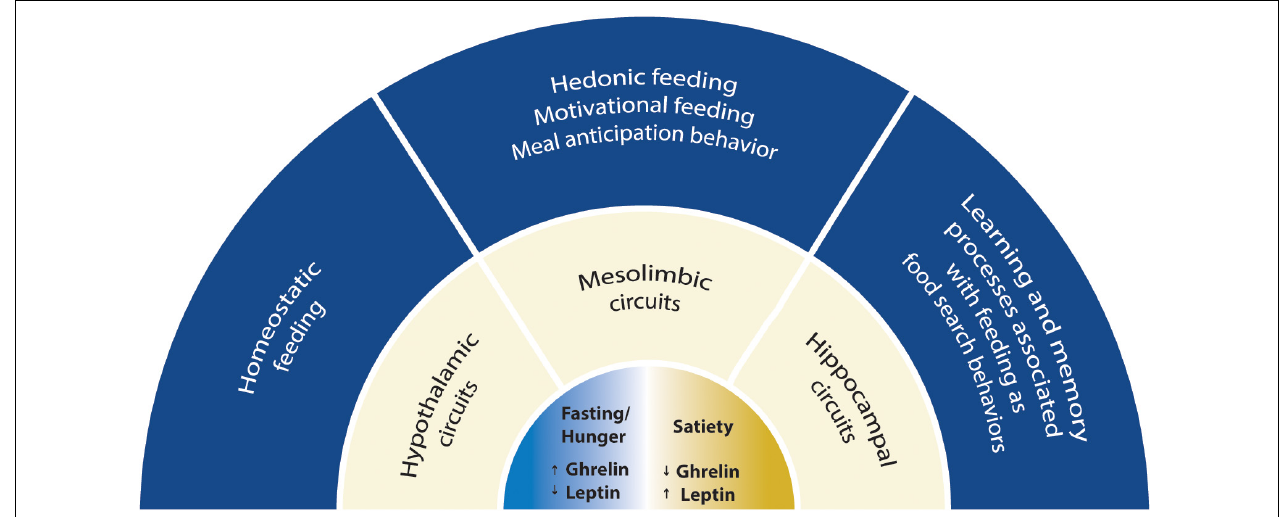
FIGURE 1 | Scheme with the scope of this review. The mechanisms for synaptic plasticity modulated by ghrelin are discussed in three main neuronal circuits associated with feeding: the hypothalamic, the mesolimbic and the hippocampal circuits. Two energy states are represented: fasting/hunger and satiety. Fasting or hunger conditions are associated with high ghrelin and low leptin levels, while satiety is associated with low ghrelin and high leptin levels. Hypothalamic circuitry drives food intake depending on energy store levels (homeostatic feeding), while the mesolimbic circuitry drives consumption of food with elevated rewarding properties (hedonic and motivational feeding). Hippocampal circuitry integrates feeding with cognitive behavior suggesting that ghrelin is relevant for food searches in nature and can impact cognitive